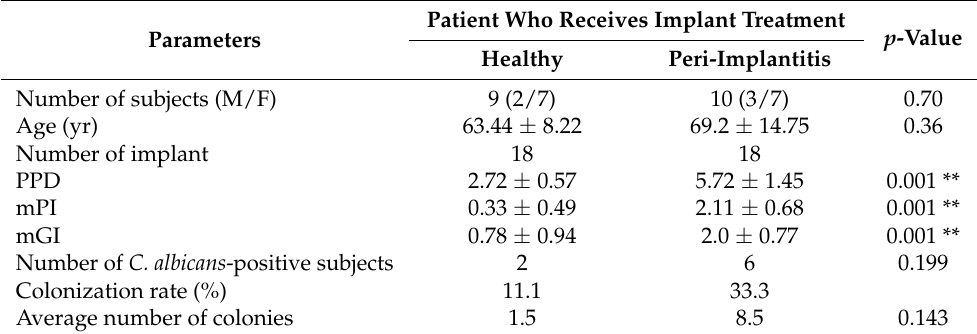
Table 1. Demographic parameters and clinical indices of health and peri-implantitis patients.